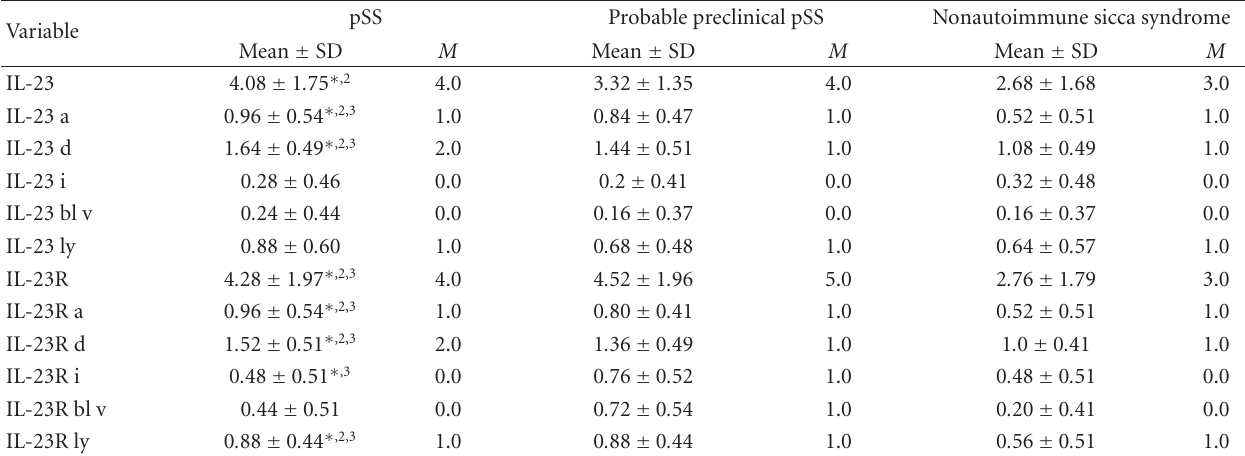
Table 3: Expression (grades) IL-23 and IL-23R in minor salivary glands of patients with primary Sj¨ogren’s syndrome (pSS), with probable preclinical primary Sj¨ogren’s syndrome (probable preclinical pSS), and with nonautoimmune sicca syndrome: ducti (d), acini (a), blood vessels (bl v), interstitium (i), lymphocytes (ly)], [mean ± SD, median ( M